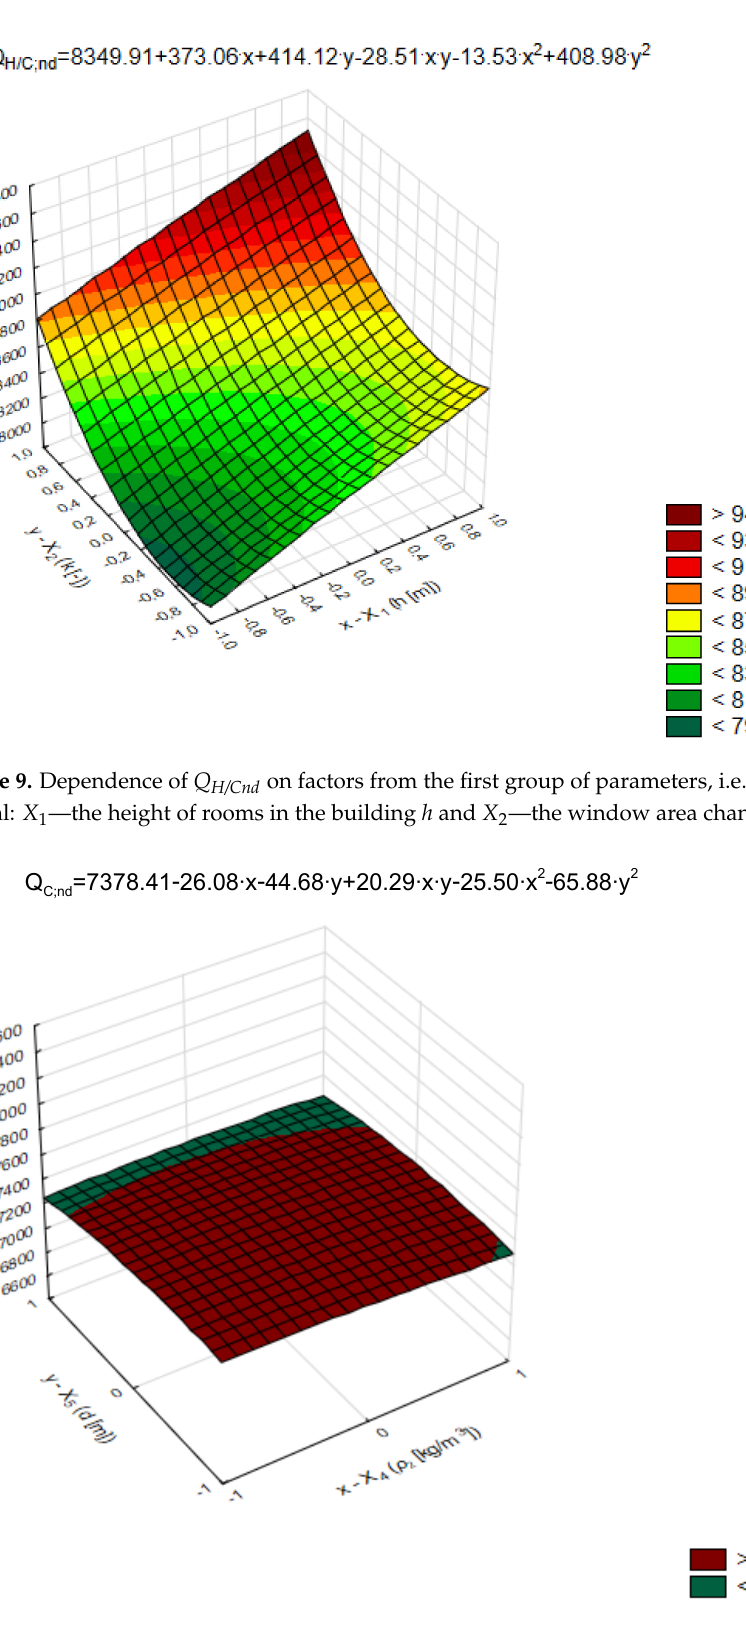
Figure 10 Figure 10. Dependence of Q Hnd on two most important factors from the second group of parameters, i.e., structural, concerning the solutions of building elements: X 4 —density of material of internal wall ρ 2 and X 5 —thickness of internal walls d